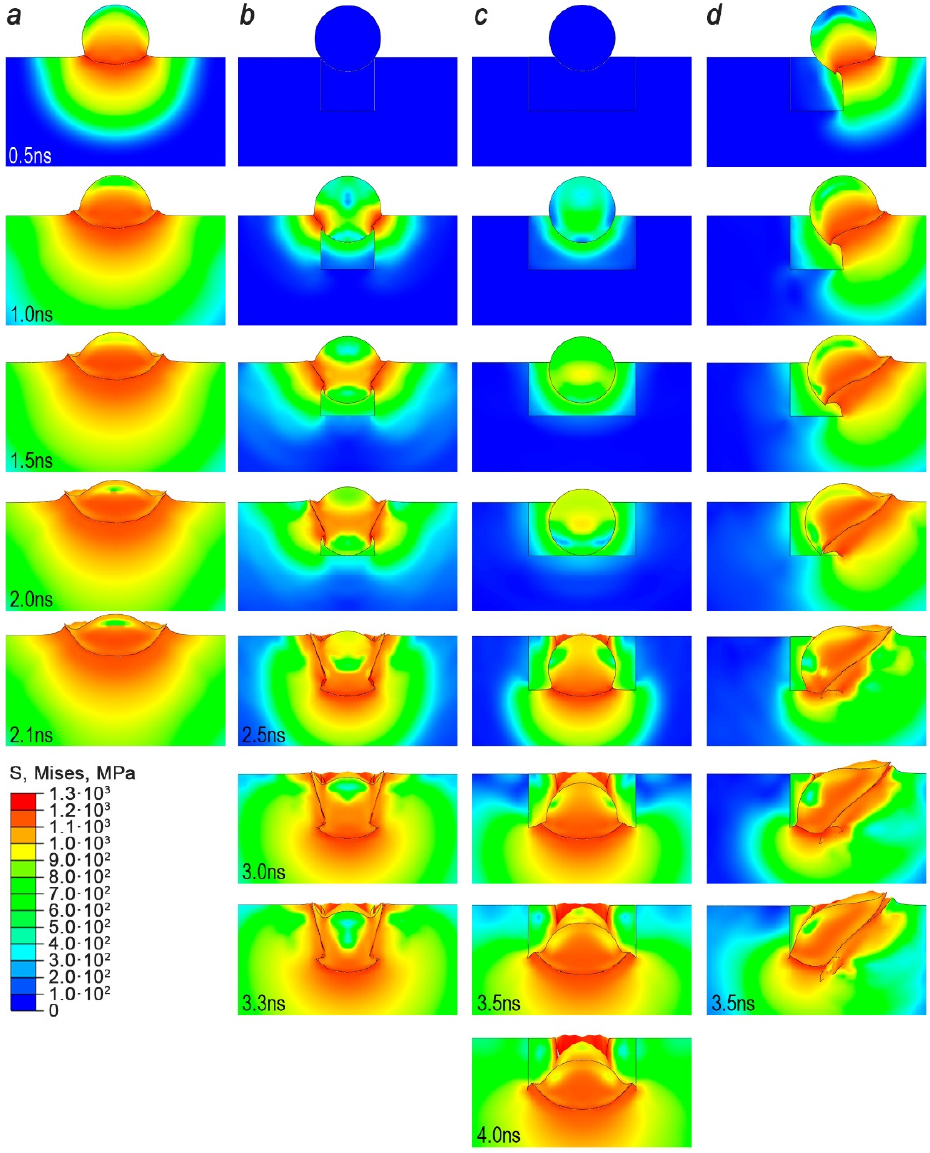
Figure 9. The von Mises stress distribution in the particle ( d P = 2.1 µ m) and substrate material during impact time: ( a ) without microdefect; ( b ) with cube-shaped microdefect; ( c ) with rectangular-shaped microdefect; ( d ) with the particle collision on the edge of cube-shaped microdefect.